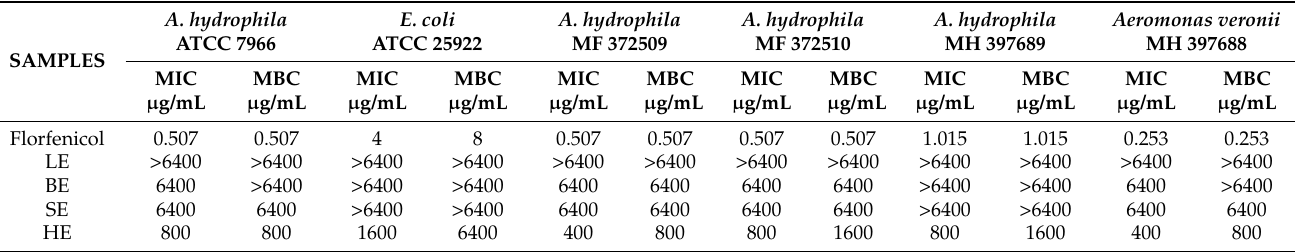
Table 5. Minimum Inhibitory Concentration (MIC) and Minimum Bactericidal Concentration (MBC) of florfenicol and Maclura tinctoria extracts from leaves (LE), bark (BE), sapwood (SE), and heartwood (HE) against reference strains and Aeromonas isolated from